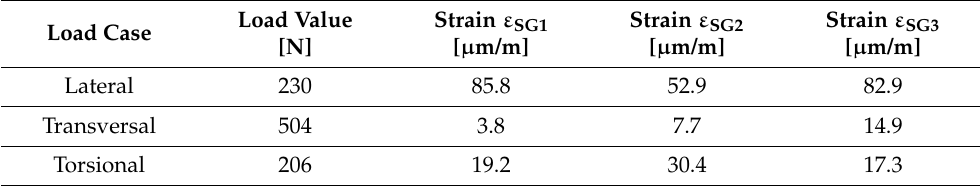
Table 13. Computed strains on the outer and inner surface of the composite hood “B”.